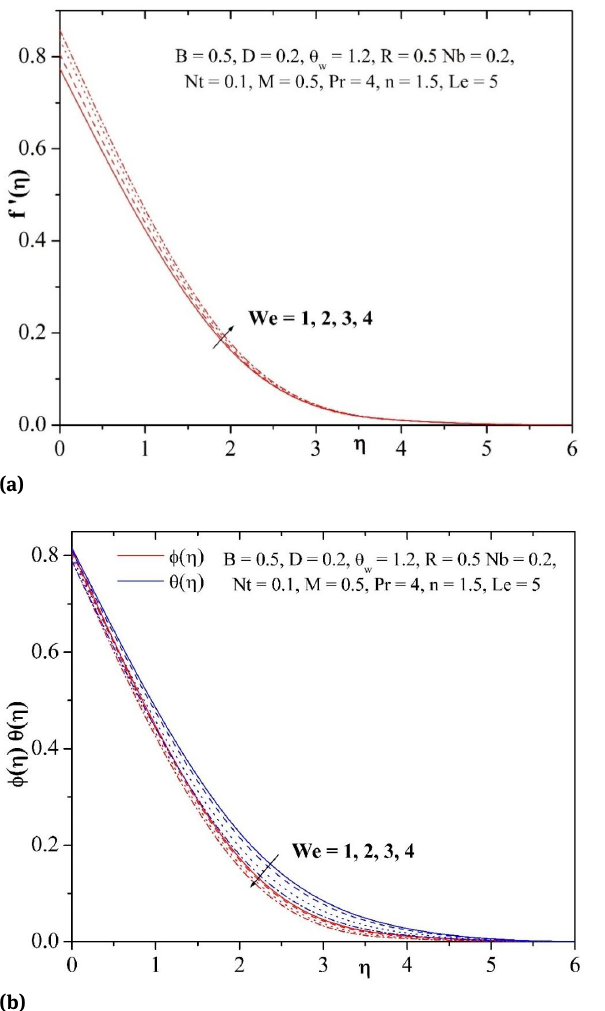
Fig. 3: (a) Influence of n on velocity profile. (b)Influence of n on temperature and concentration